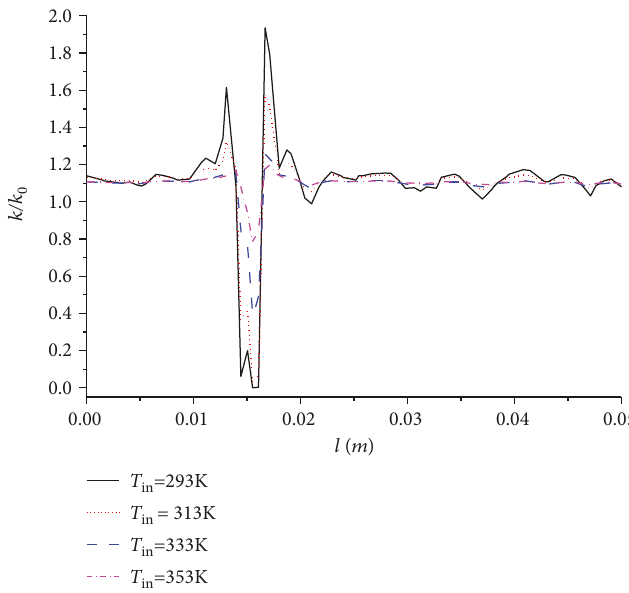
Figure 21: The evolution of permeability ratio k / k